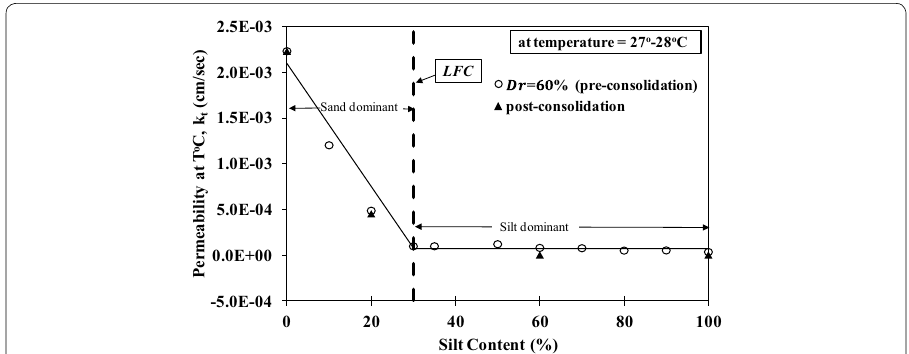
Fig. 27 Effect of silt content on coefficient of permeability of sand–silt mixture at Canstant relative density of